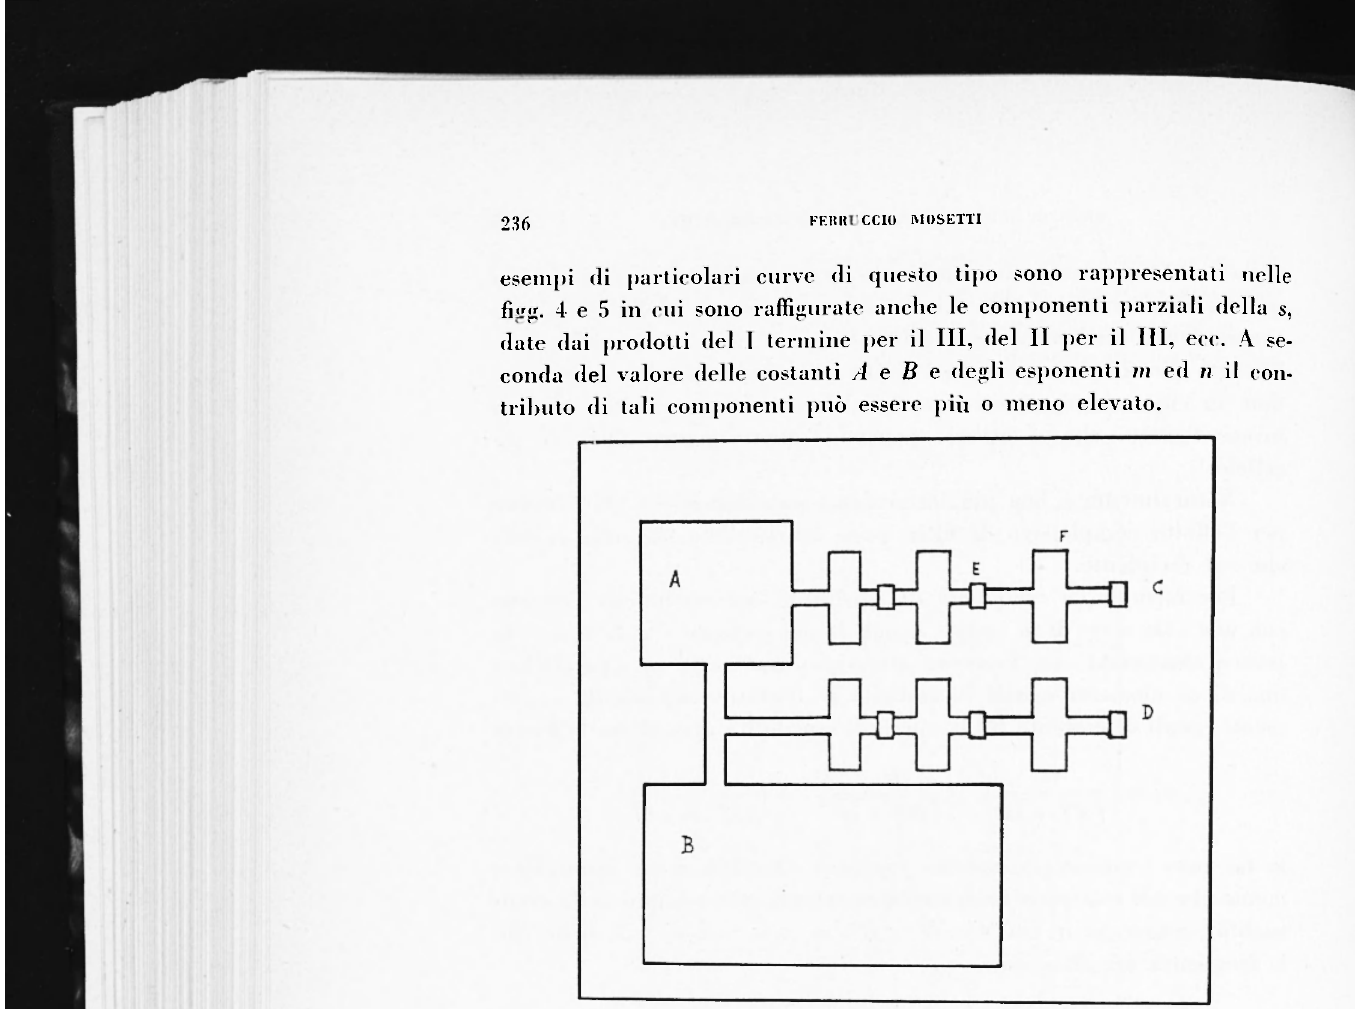
Fig. 6 - Schema di principio de! nuovo microbarografo : A registratore con scatola ermetica; B recipiente di capacità; C filtri per le onde brevi; D filtri per le onde lunghe; E capillare graduato; F scatoletta di